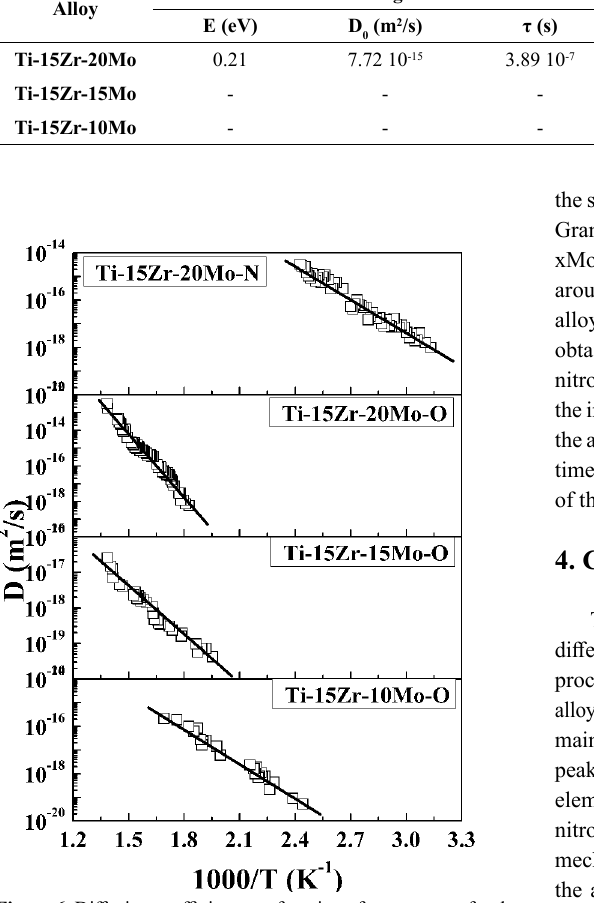
Figure 6. Diffusion coefficient as a function of temperature for the alloys of Ti-15Zr-Mo system.